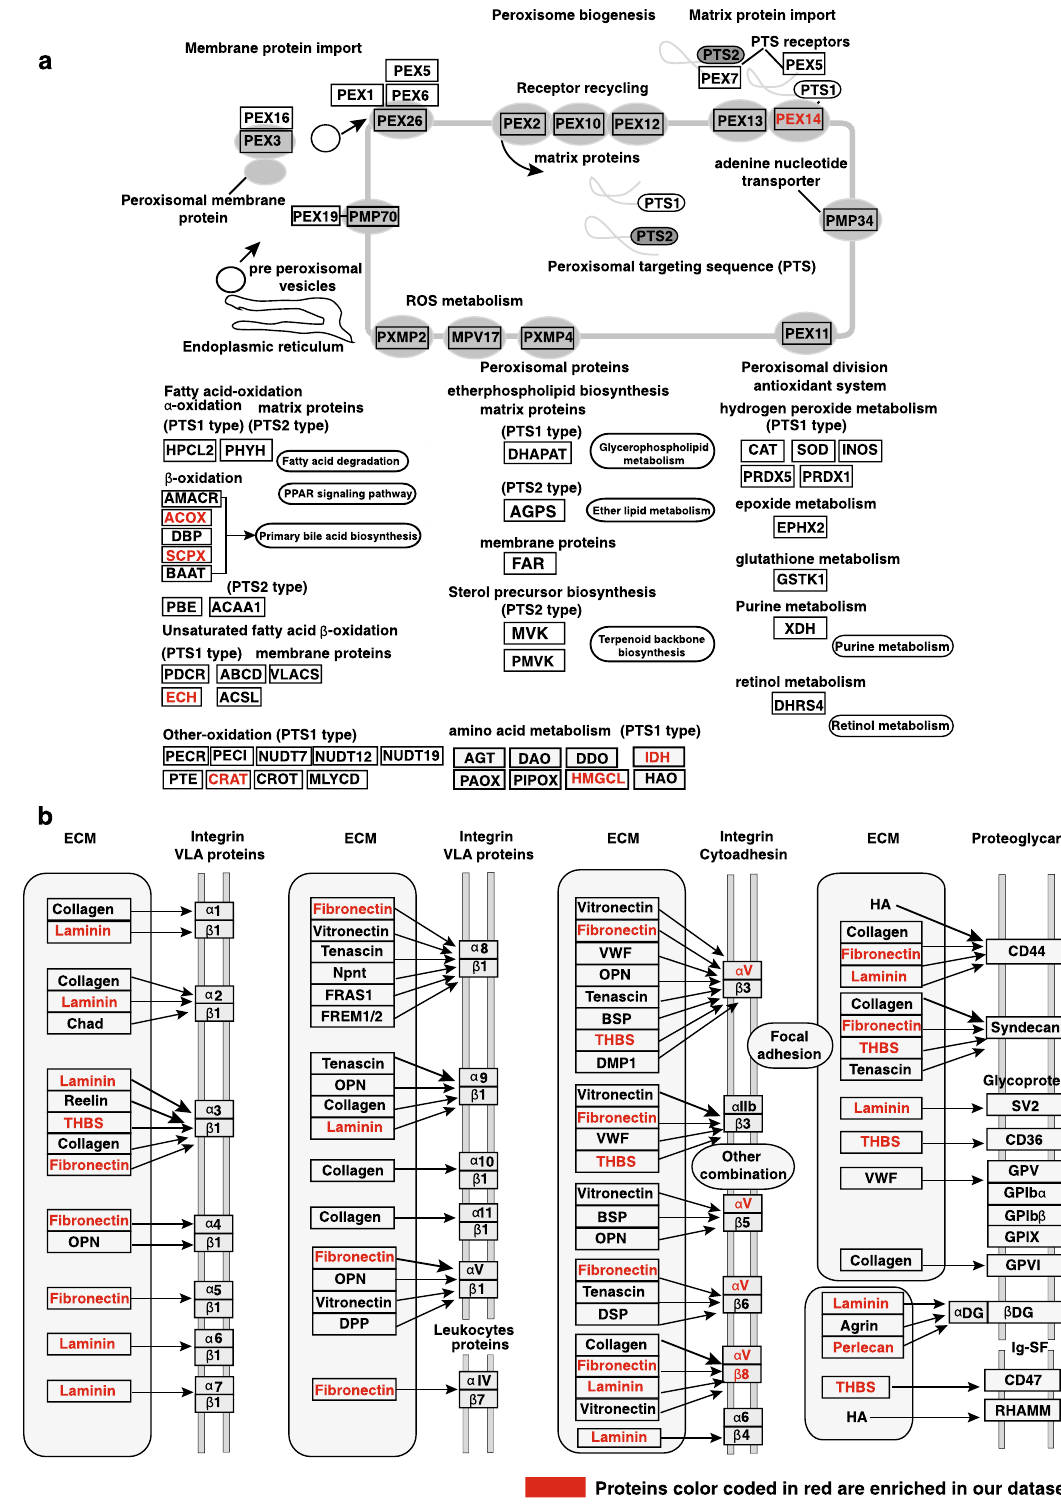
Figure 2. Chronic treatment with shammah induces signaling associated with extracellular matrix and peroxisomal biogenesis. Kyoto Encyclopedia of Genes and Genomes (KEGG) 80 pathway analysis of overexpressed and/or hyperphosphorylated proteins ( a ) overexpressed and/or hyperphosphorylated proteins showed enrichment of peroxisome mediated long chain fatty acid oxidation and ( b ) enrichment of proteins in extracellular matrix organization (ECM). Proteins color coded in red are enriched in our